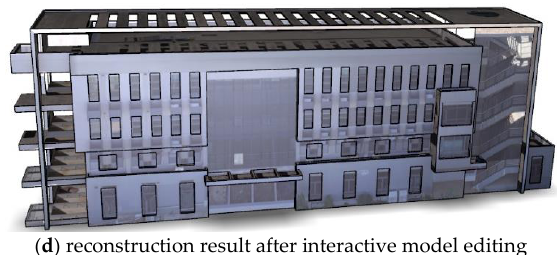
Figure 13. Reconstruction result before and after interactive model editing.